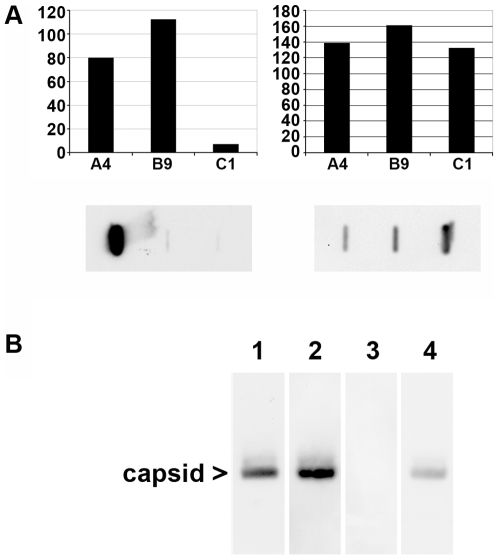
Characterization of anti capsid antibodies using capsid subassemblies.A. Immune reactivity of capsids and subassemblies using DAKO Ab (left panel) and FAb3105 (right panel). The graphs show the reactivity normalized to the protein amount (arbitrary units). The fractions are given below the x-axes. The reactivity on the y-axes is depicted in arbitrary units. The panels below are dot blots using peaks A-C from Fig. 3B(DAKO Ab) or from Fig. 3D(Fab3105). The graphs show that the polyclonal DAKO Ab reacts with capsids and fraction B9, while the FAb3105 reacted with all fractions equally well. B. Interference between DAKO Ab and FAb3105 binding to rC separation on native agarose gel electrophoresis. 1. 1st Ab: DAKO Ab, 2nd Ab: horse radish peroxidase-labelled (POD) anti rabbit. 2. 1st Ab: FAb3105, 2nd Ab: POD anti mouse. 3. 1st Ab: DAKO Ab followed by FAb3105, 2nd Ab: POD anti mouse. 4. 1st Ab FAb3105 followed by DAKO Ab, 2nd Ab: POD anti rabbit. The blots show that preincubation with DAKO Ab totally prevented capsid interaction with FAb3105 while preincubation with FAb3105 inhibited DAKO Ab reactivity significantly but not completely.